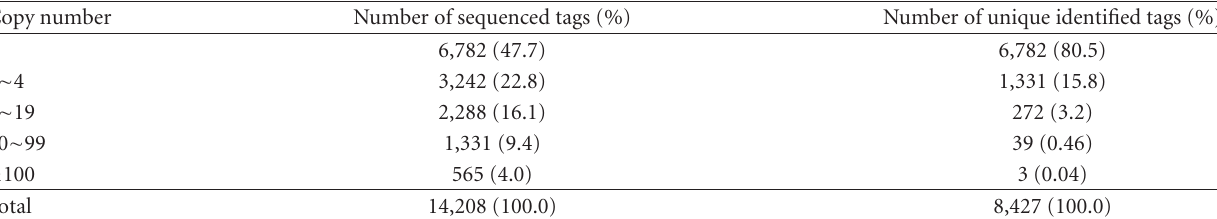
Table 1: Summary of the serial analysis of gene expression in L. i. chagasi promastigotes.